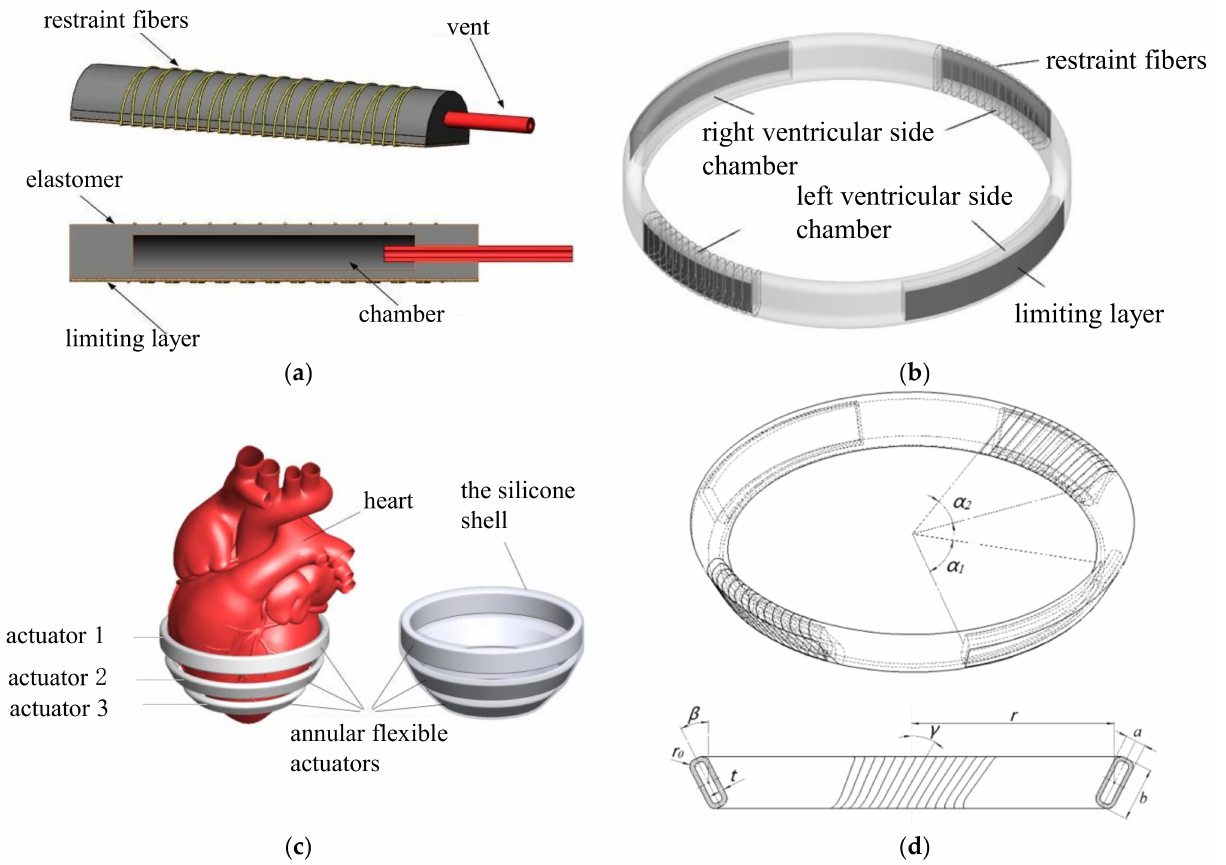
Figure 1. Structural design of fiber-constrained flexible actuator. ( a ) Fiber-constrained flexible actua- tor; ( b ) fiber-constrained annular flexible actuator; ( c ) arrangement of fiber-constrained annular flexi- ble actuators and direct ventricular assist devices; ( d ) structural parameters of the fiber-constrained annular flexible actuator, where α 1 is the ventricular balloon circumferential angle, α 2 is the septal balloon circumferential angle, r is the actuator radius, a is the cross-sectional width, b is the section length, t is the balloon wall thickness, r 0 is the balloon circumferential radius, β is the actuator inclination angle, γ is the fiber inclination angle and ρ is the fiber